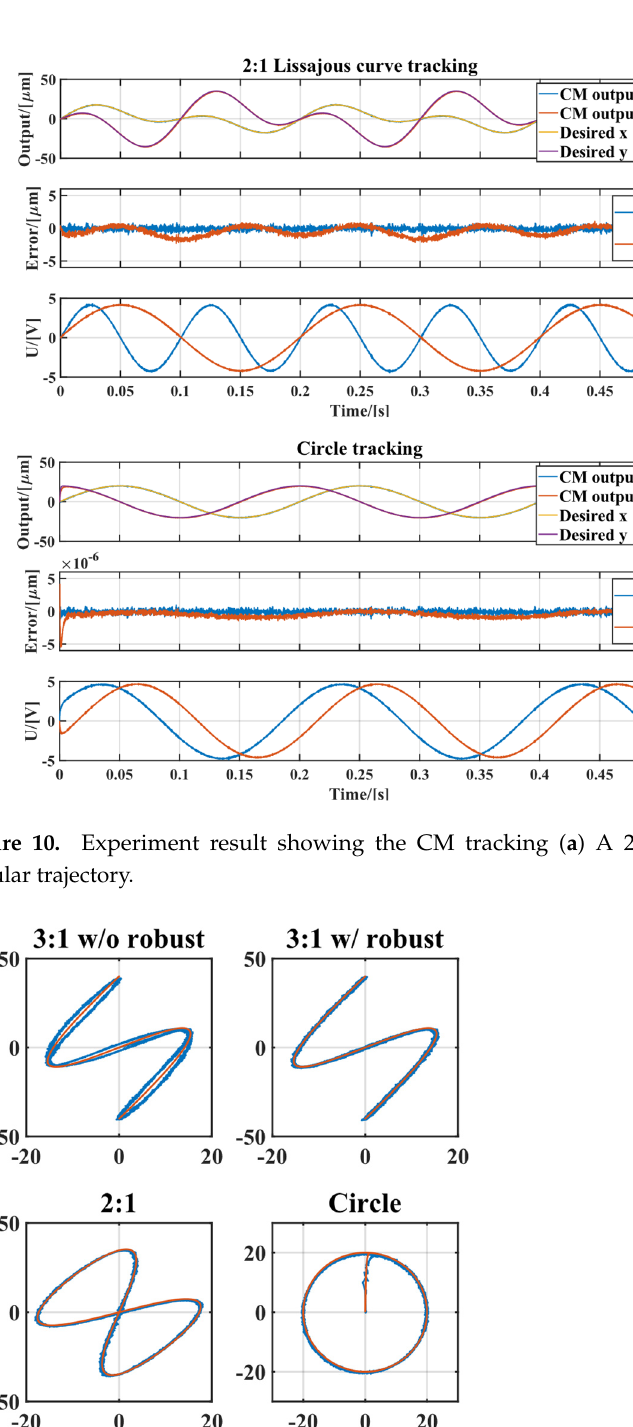
Figure 9. Experiment result showing a comparison between ( a ) Tracking of 3:1 Lissajous curve with ‐ out the robust controller and ( b ) Tracking of 3:1 Lissajous curve with the robust controller.